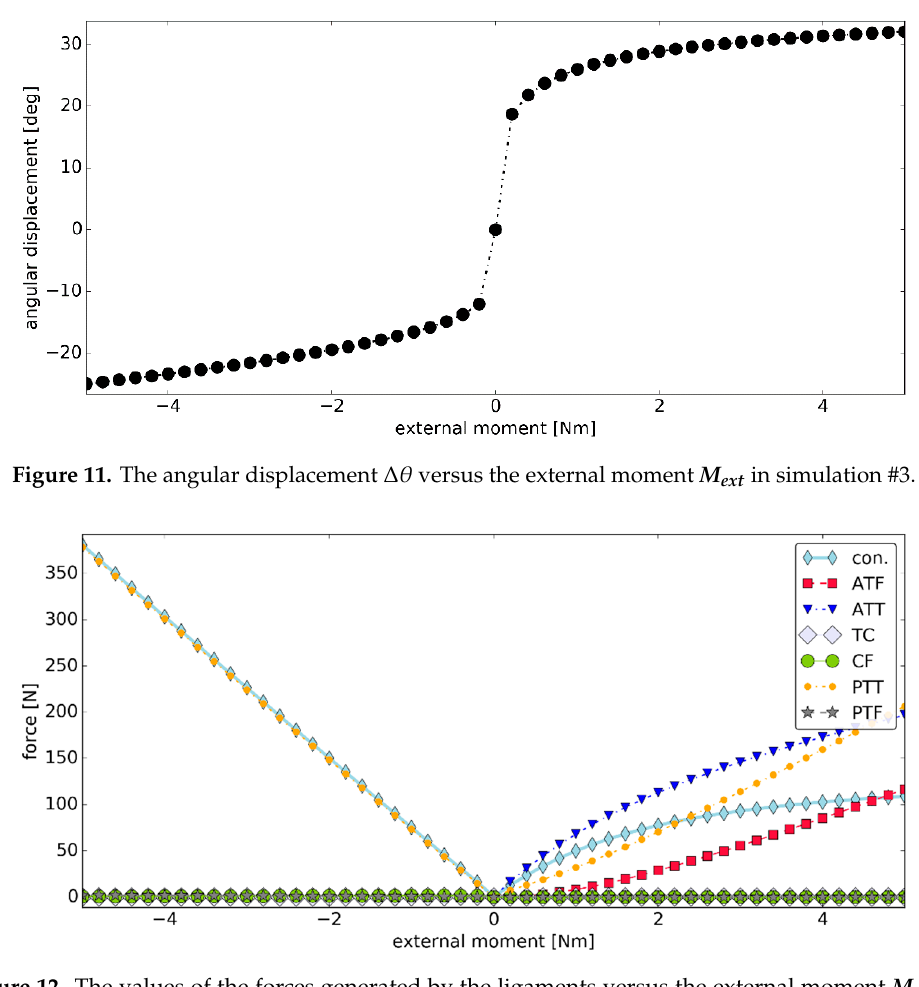
Figure 12. The values of the forces generated by the ligaments versus the external moment M ext in simulation #3, where "con." is the magnitude of the contact force generated by the two contact